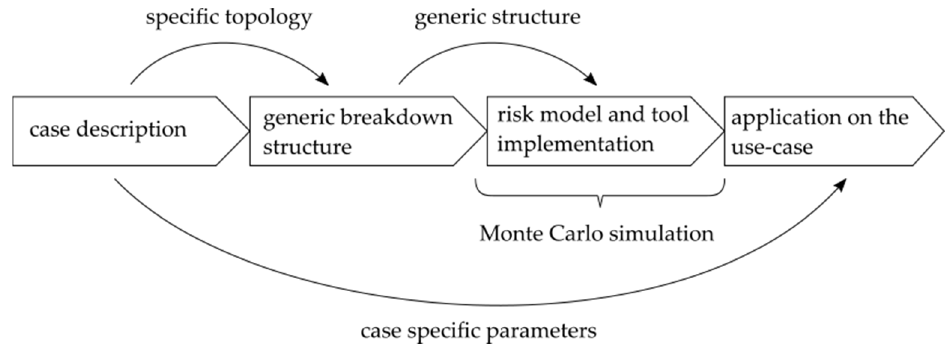
Figure 2. Procedure and